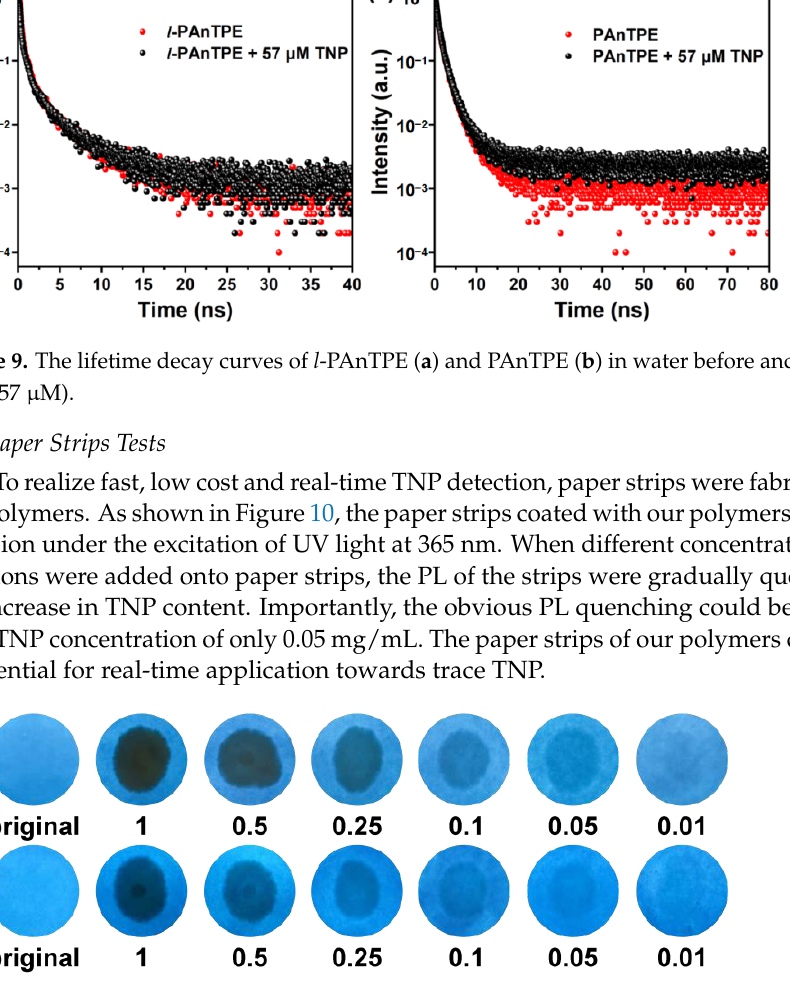
Figure 10. Paper strips of l -PAnTPE ( a ) and PAnTPE ( b ) before and after adding TNP solution (concentration: 0.01, 0.05, 0.1, 0.25, 0.5, 1 mg/mL, respectively).